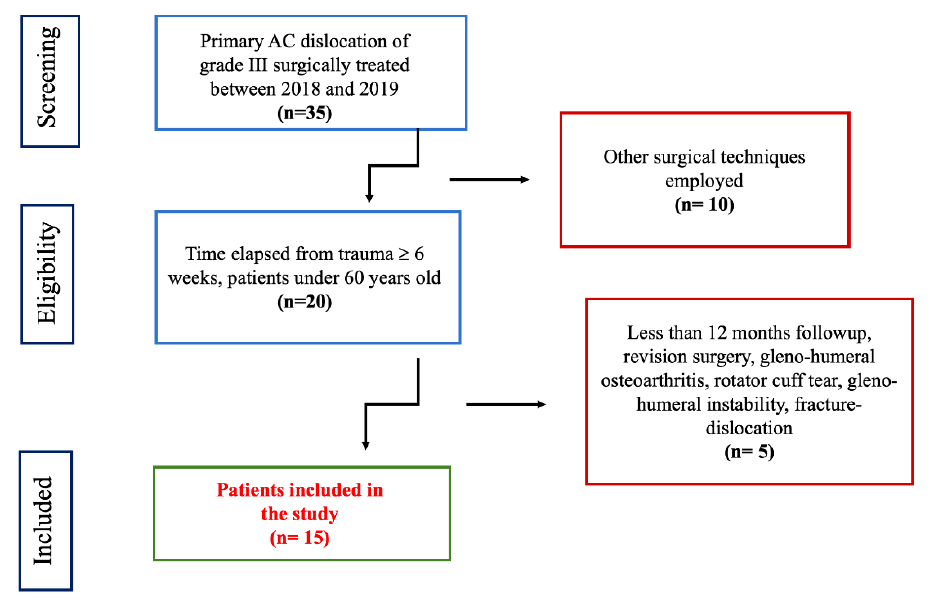
Scheme 1. Patients recruiting Scheme 1 . Patients recruiting process.